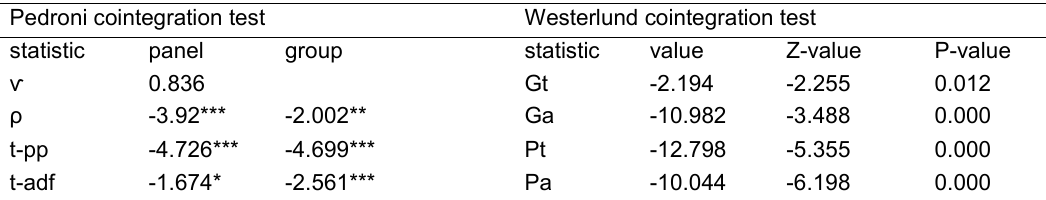
Table 8. Panel cointegration tests